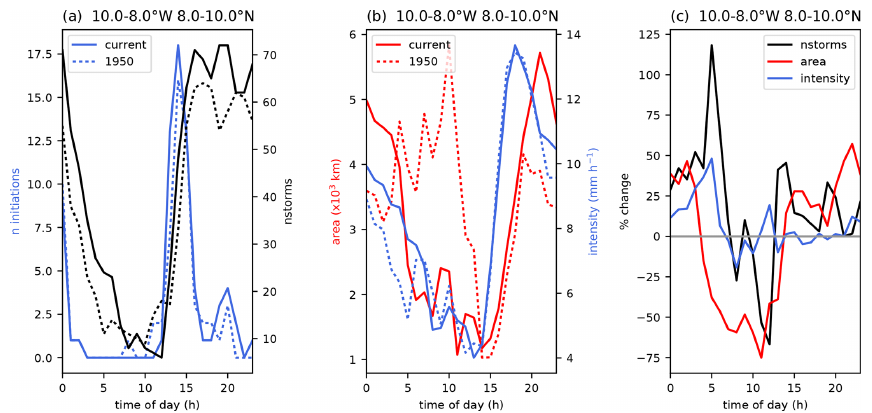
Figure 9. Diurnal cycles in the region 10–8 ◦ W, 8–10 ◦ N of (a) number of spontaneous initiations (light blue) and number of storms present (black); (b) mean area (red) and mean intensity (light blue) of storms; and (c) the percent change in number of storms (black), mean area (red), and mean intensity (light